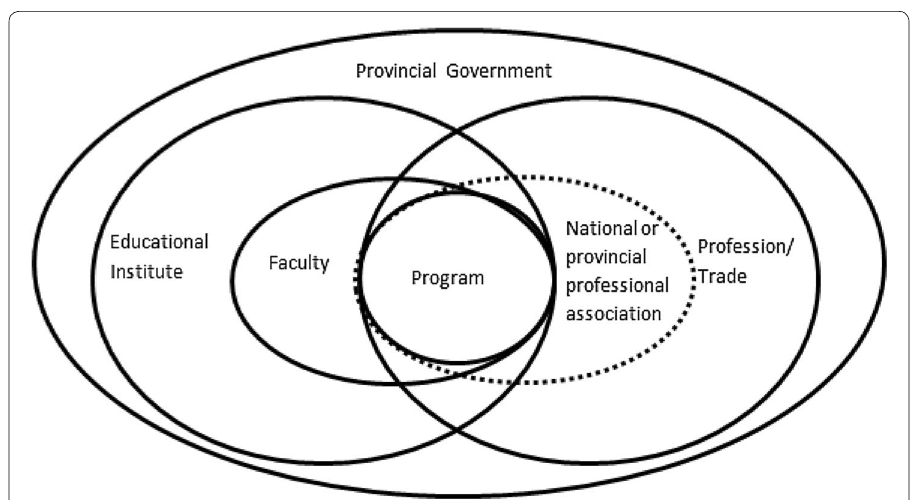
Fig. 1 Depiction of how VPE departments are situated within their